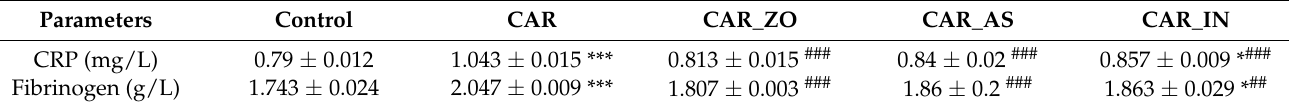
Table 1. Inflammatory biomarkers in the serum of the different experimental rats: control rats, inflamed rats with CAR (CAR), inflamed rats pre-treated with ZO (CAR_ZO), inflamed rats treated with AS (CAR_AS) and inflamed rats treated with IN (CAR_IN). Parameters